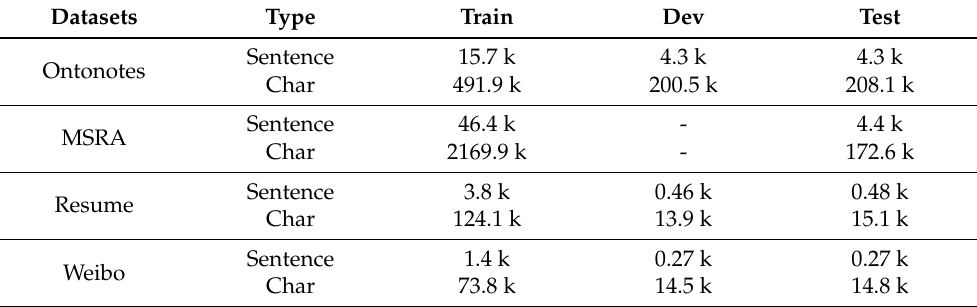
Table 1. Statistics of